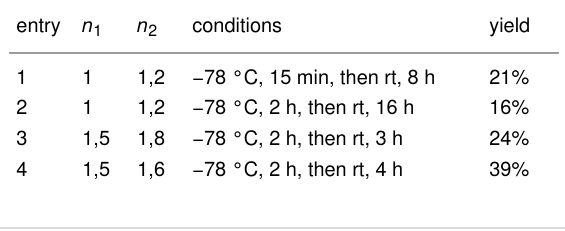
Table 1: Coupling reaction between alkyne 19 and ketone 11b